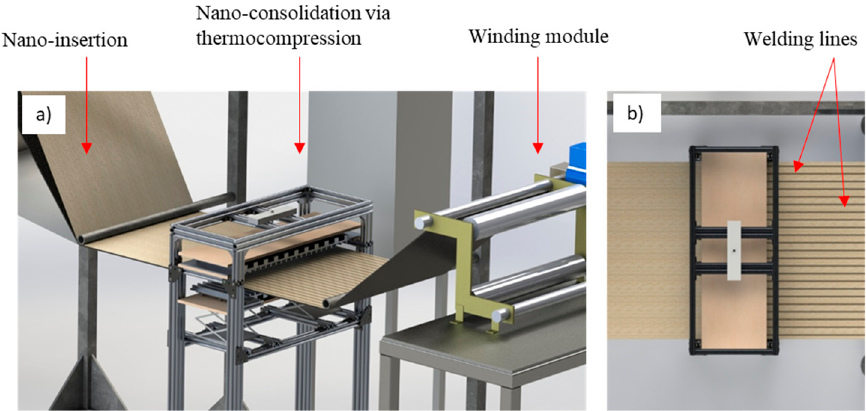
Figure 3. ( a ) Three-dimensional rendering of the thermo-compression module. ( b ) Multiple welding lines on the consolidation module of the inserted nanofabric via thermal welding.